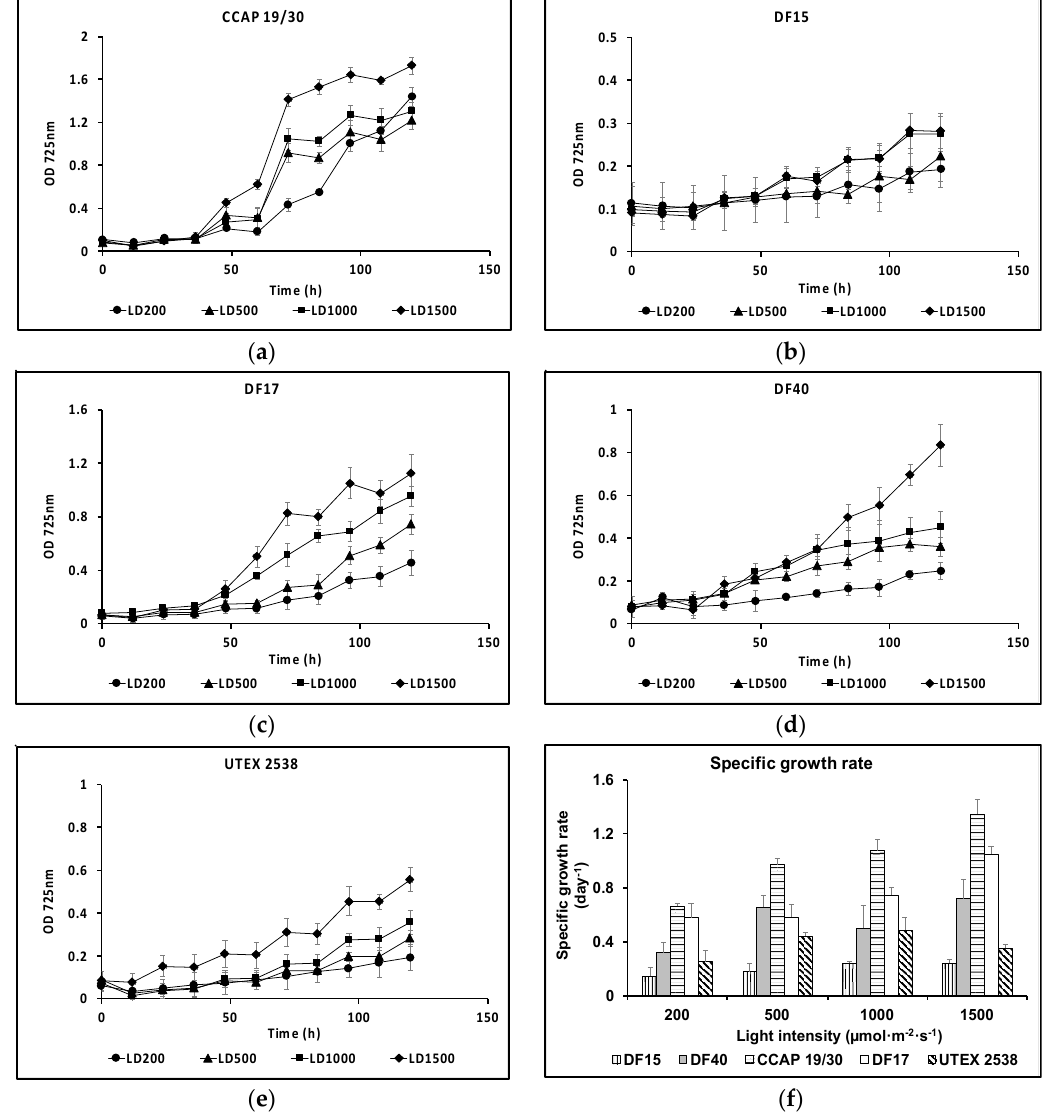
Figure 2. Growth curves for the five Dunaliella strains: ( a ) CCAP 19/30; ( b ) DF15; ( c ) DF17; ( d ) DF40; ( e ) UTEX 2538 each grown under four identical light intensities of 200, 500, 1000 and 1500 µmol·m − 2 ·s − 1 at a light/dark cycle of 12 h light and 12 h dark (LD200, LD500, LD1000 and LD1500); ( f ) specific growth rates of each strain grown under the four light intensities. Each culture condition was set up in triplicate.